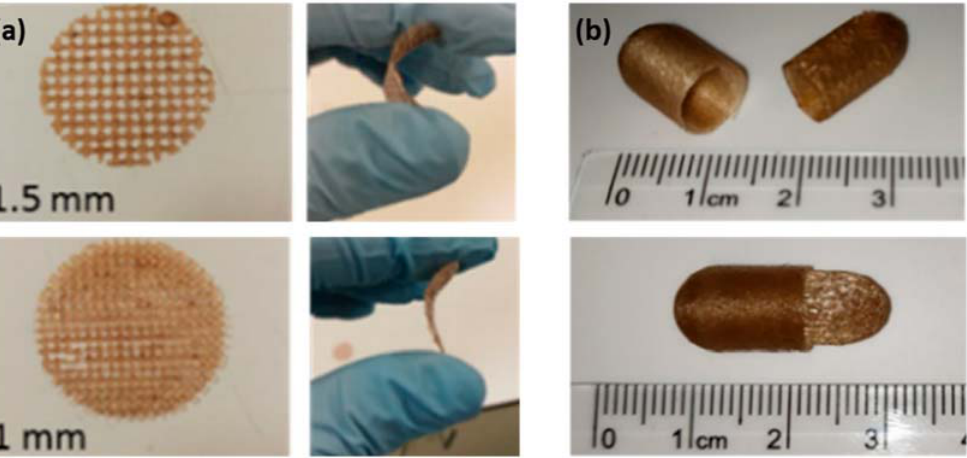
Figure 9. 3D printed ( a ) meshes and ( b ) oral capsules (reproduced from Ref. [16] with permission from the